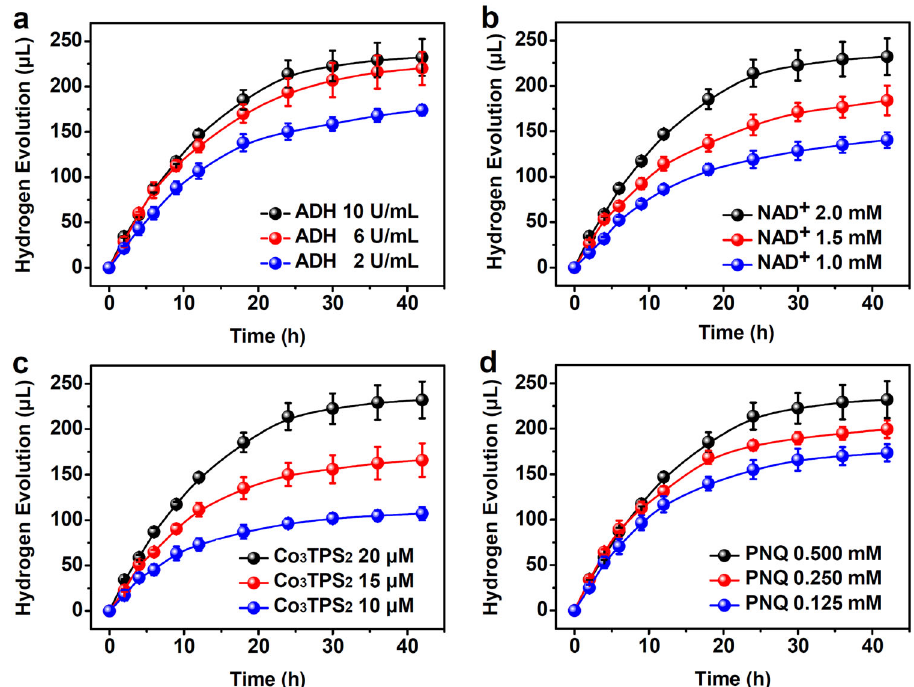
Fig. 4 Kinetics of the photocatalytic hydrogen evolution from alcohol dehydrogenation. Hydrogen evolution in EtOH/H 2 O (3:2, pH 4.5) a as a function of the concentration of ADH with NAD + (2.0 mM), Co 3 TPS 2 (20.0 μ M) and PNQ (0.5 mM) remaining fi xed; b as a function of the concentration of NAD + with ADH (10 U mL − 1 ), Co 3 TPS 2 (20.0 μ M) and PNQ (0.5 mM) remaining fi xed; c as a function of the concentration of Co 3 TPS 2 with ADH (10 U mL − 1 ), NAD + (2.0 mM) and 0.5 mM PNQ remaining fi xed; d as a function of the concentration of PNQ with ADH (10 U mL − 1 ), NAD + (2.0 mM) and Co 3 TPS 2 (20.0 μ M) remaining fi xed. Data points and error bars represent the mean ± s.d. of three independent experiments in all fi